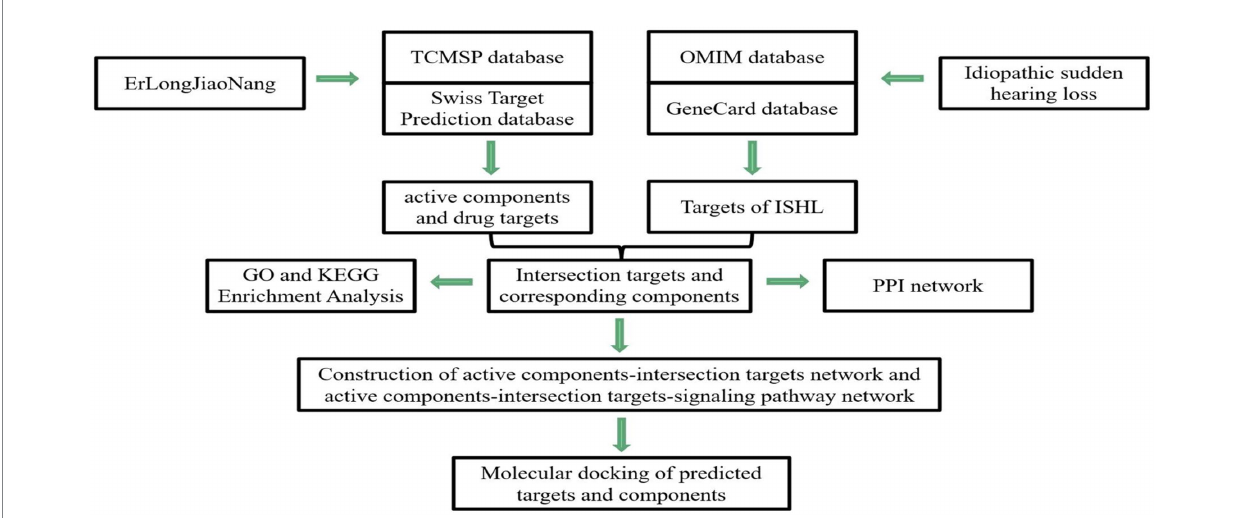
FIGURE 1 Illustration of study flow and data analysis. In this study, we first identified the possible active components in ELJN and then searched for their molecular targets. Meanwhile, we also identified ISHL-related genes. Subsequently, we constructed different networks to analyze the interaction of these two types of genes molecularly and then molecular docking analysis of the genes targeted by the active components of